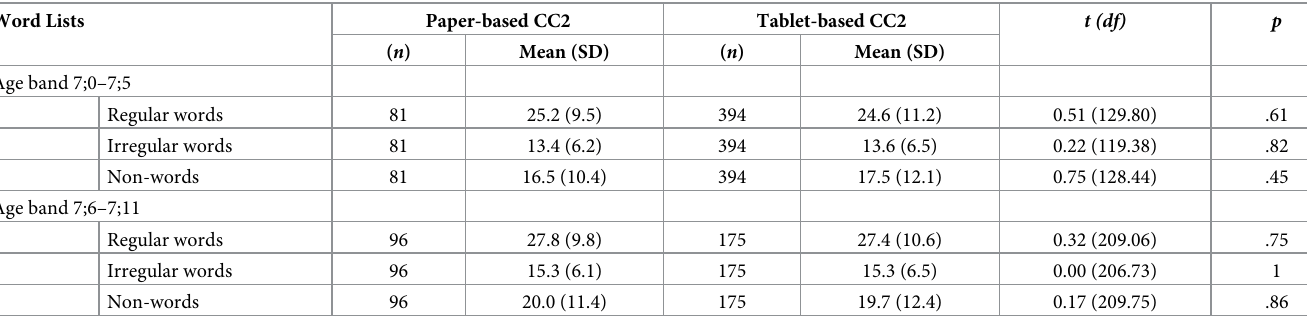
Table 1. T-test results comparing normative with tablet-administered